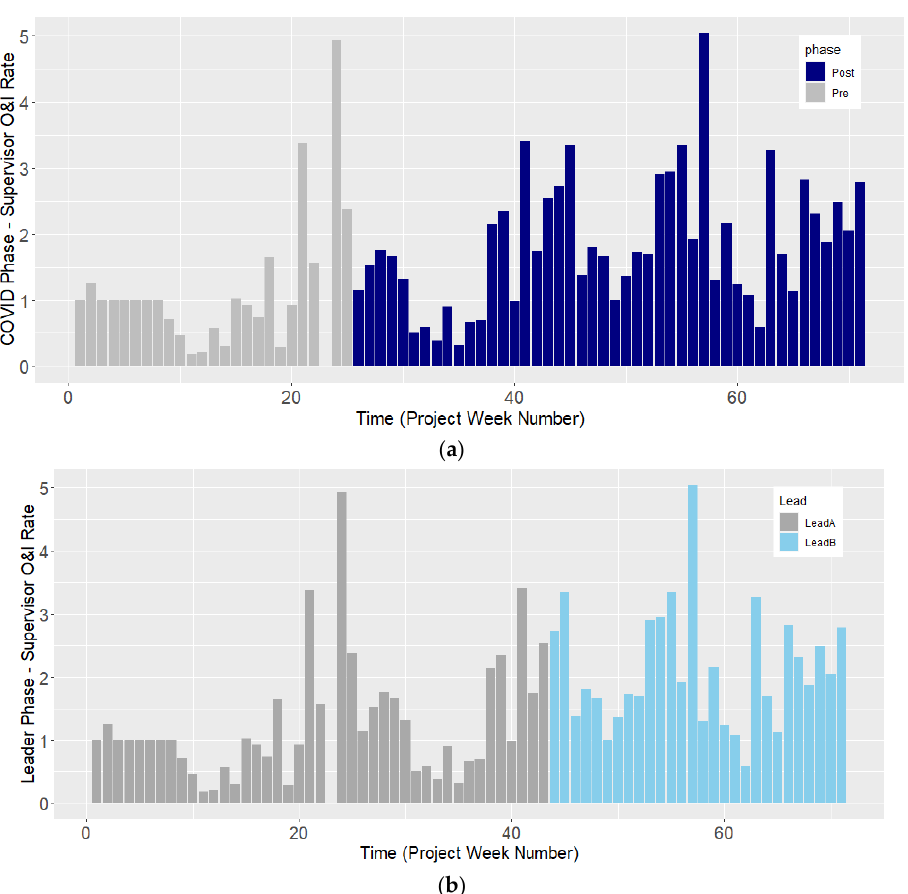
Figure 10. ( a ) Supervisor observation & intervention rate by COVID Phase, ( b ) Supervisor observation & intervention rate under different Project Leaders.